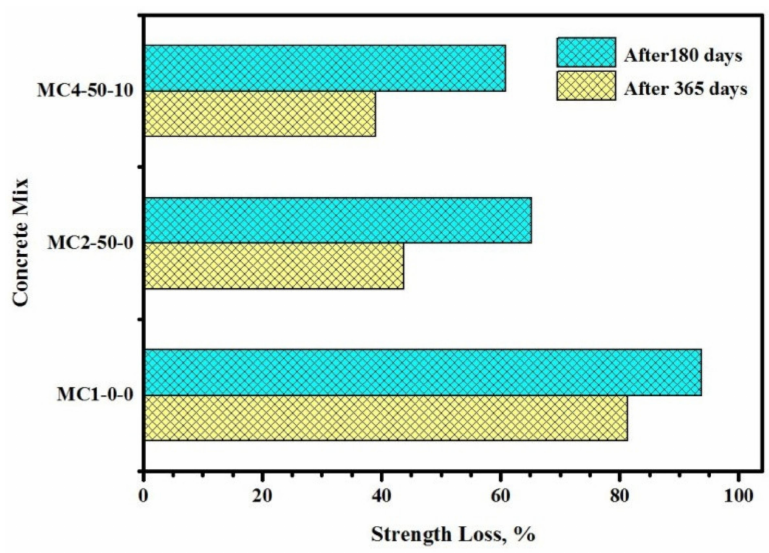
Figure 10. Influence of FA and EM on CS loss of the bio-concretes exposed to 10% of H 2 SO 4